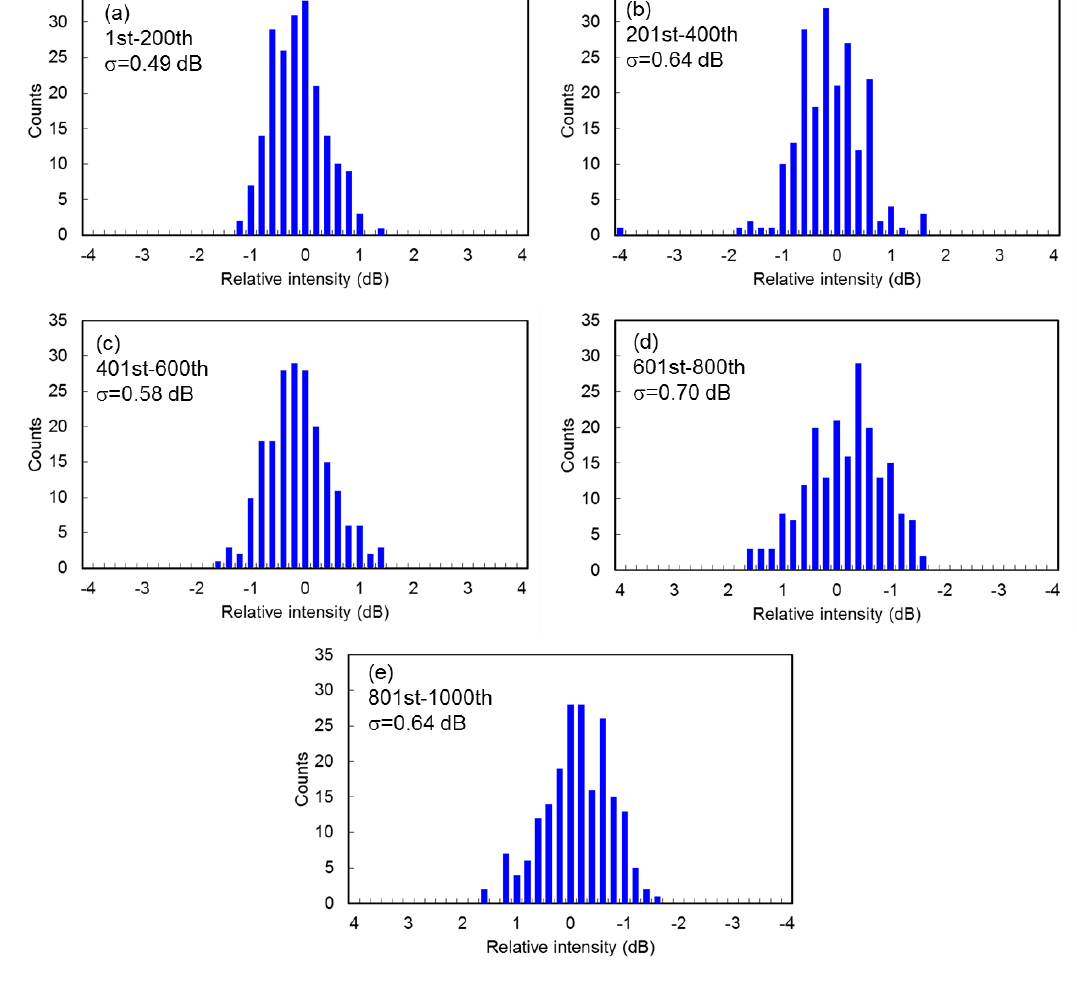
Figure 5. Histograms of relative intensity of 200 output ports at ( a ) first LD array; ( b ) second LD array; ( c ) third LD array, ( d ) fourth LD array; ( e ) fifth LD